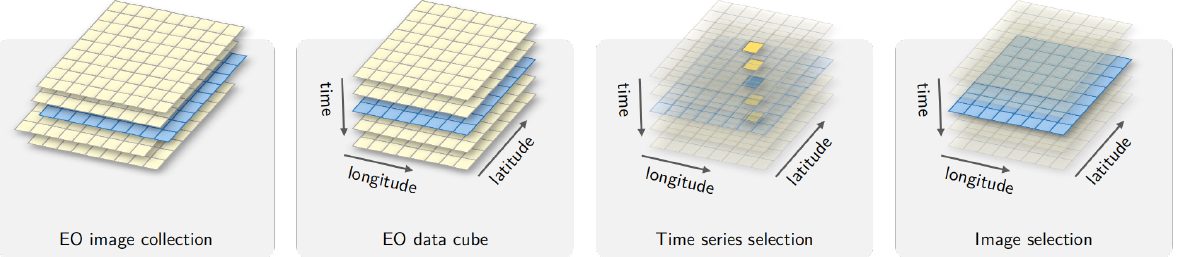
Figure 1. Conceptual view of data cubes (source: